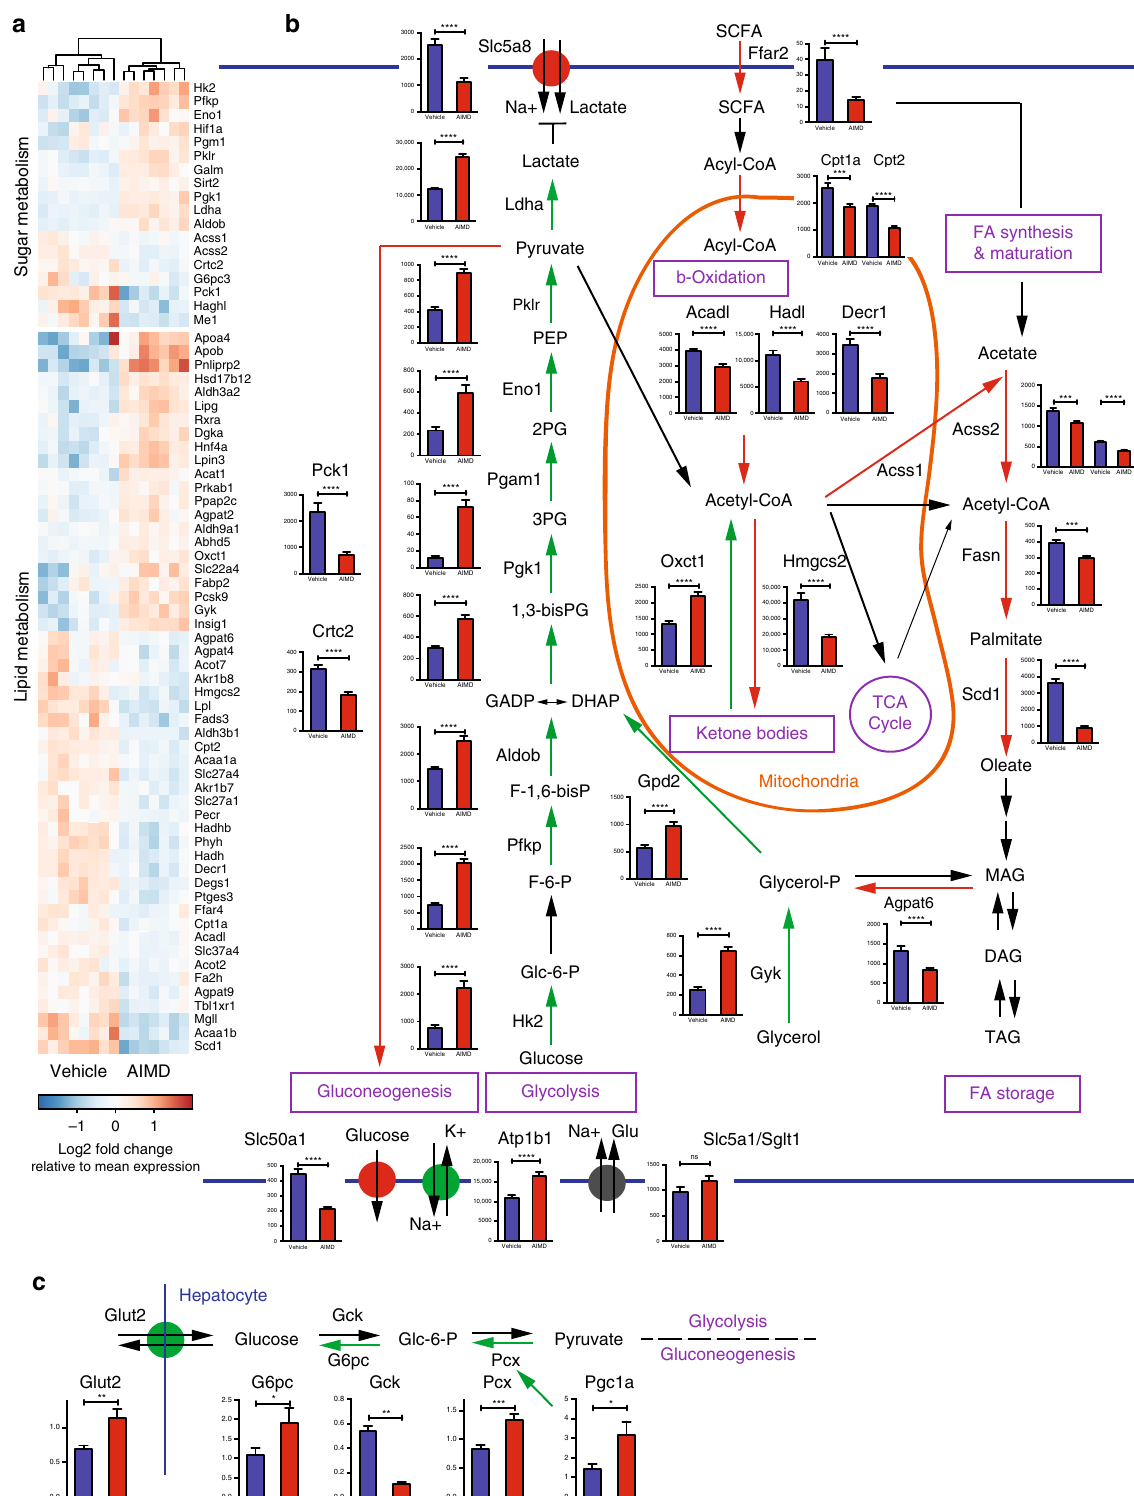
Fig. 6 Anaerobic glycolysis in the cecum is upregulated in AIMD mice. a Heatmap of differentially expressed genes involved in sugar and lipid metabolism in the cecum of vehicle and AIMD mice as assessed by RNA-sequencing analysis ( n = 7 – 8/group). b Mapping of metabolic genes onto speci fi c pathways, including gluconeogenesis and glycolysis, β -oxidation, ketone body metabolism, TCA cycle, fatty acid synthesis, maturation and storage. Adjusted p value from negative binomial Wald test (corrected for multiple hypothesis testing with the Benjamini – Hochberg method), * p < 0.05, ** p < 0.01, *** p < 0.001, **** p < 0.0001. c Quanti fi cation by qRT-PCR of Glut2, Gck, G6pc, Pcx, and Pgc1a mRNA expression in the liver (n = 8/group). Tissue collected 4 weeks after intervention. Mann – Whitney U test, * p < 0.05, ** p < 0.01, *** p < 0.001, ns nonsigni fi cant. All error bars are